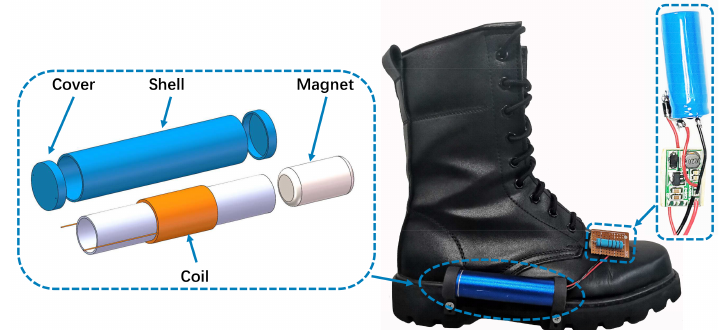
Figure 2. Energy harvesting device. The device is installed on the shoe. During the swing period of the gait, the magnet cuts the coil to generate an induced electromotive force, and the generated electrical energy is stored in the fast charging battery through the voltage stabilizing circuit.